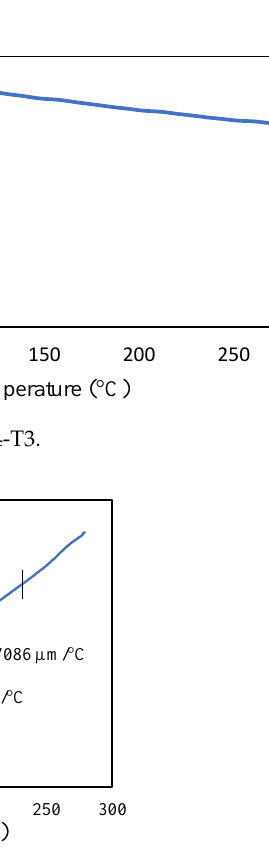
Figure 6. Thermal expansion of healthy specimen.